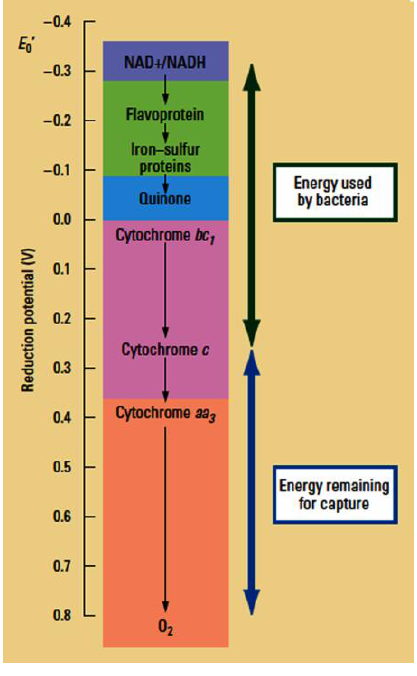
Figure 7. Microbial Fuel Cell (MFC) Respiratory Chain Diagram, which shows how energy can be recovered for the fuel cell from the potential between cytochrome c and oxygen. Figure adapted from reference